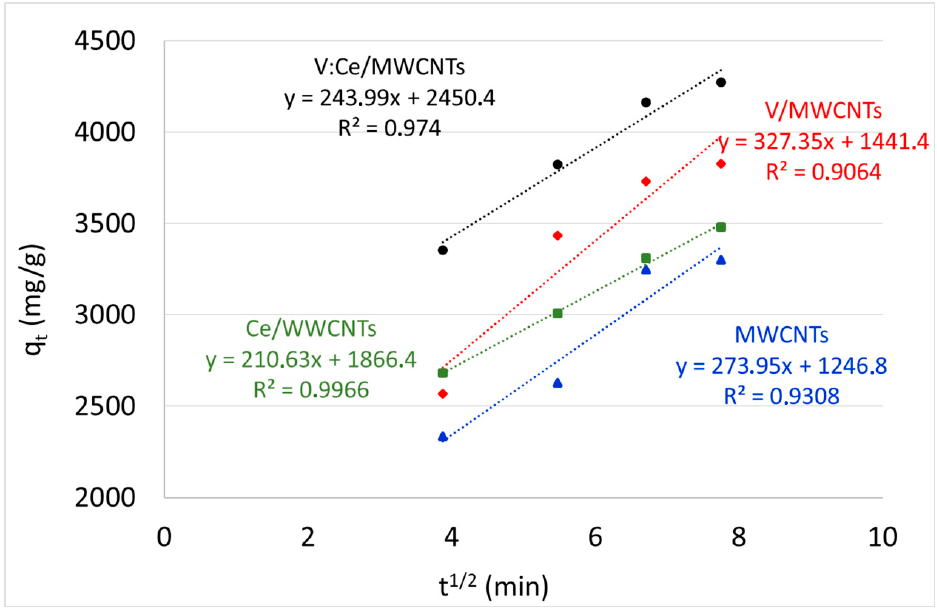
Figure 12. Intra-particle diffusion plot with regard to kerosene adsorption for metal oxide-modified MWCNTs.